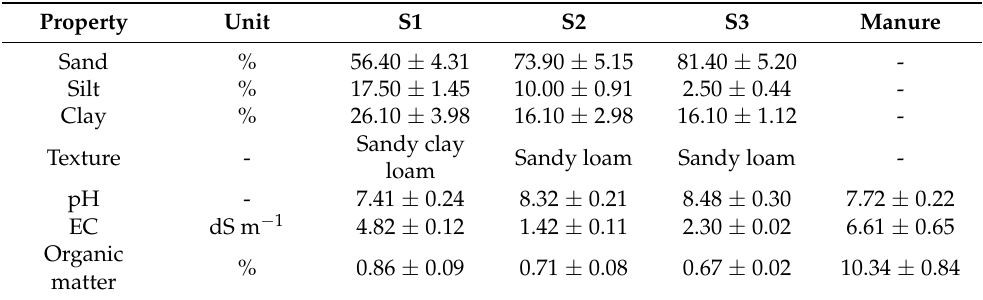
Table 1. Selected physiochemical properties and proximate attributes of soils (S1, S2, and S3) and manure used in this